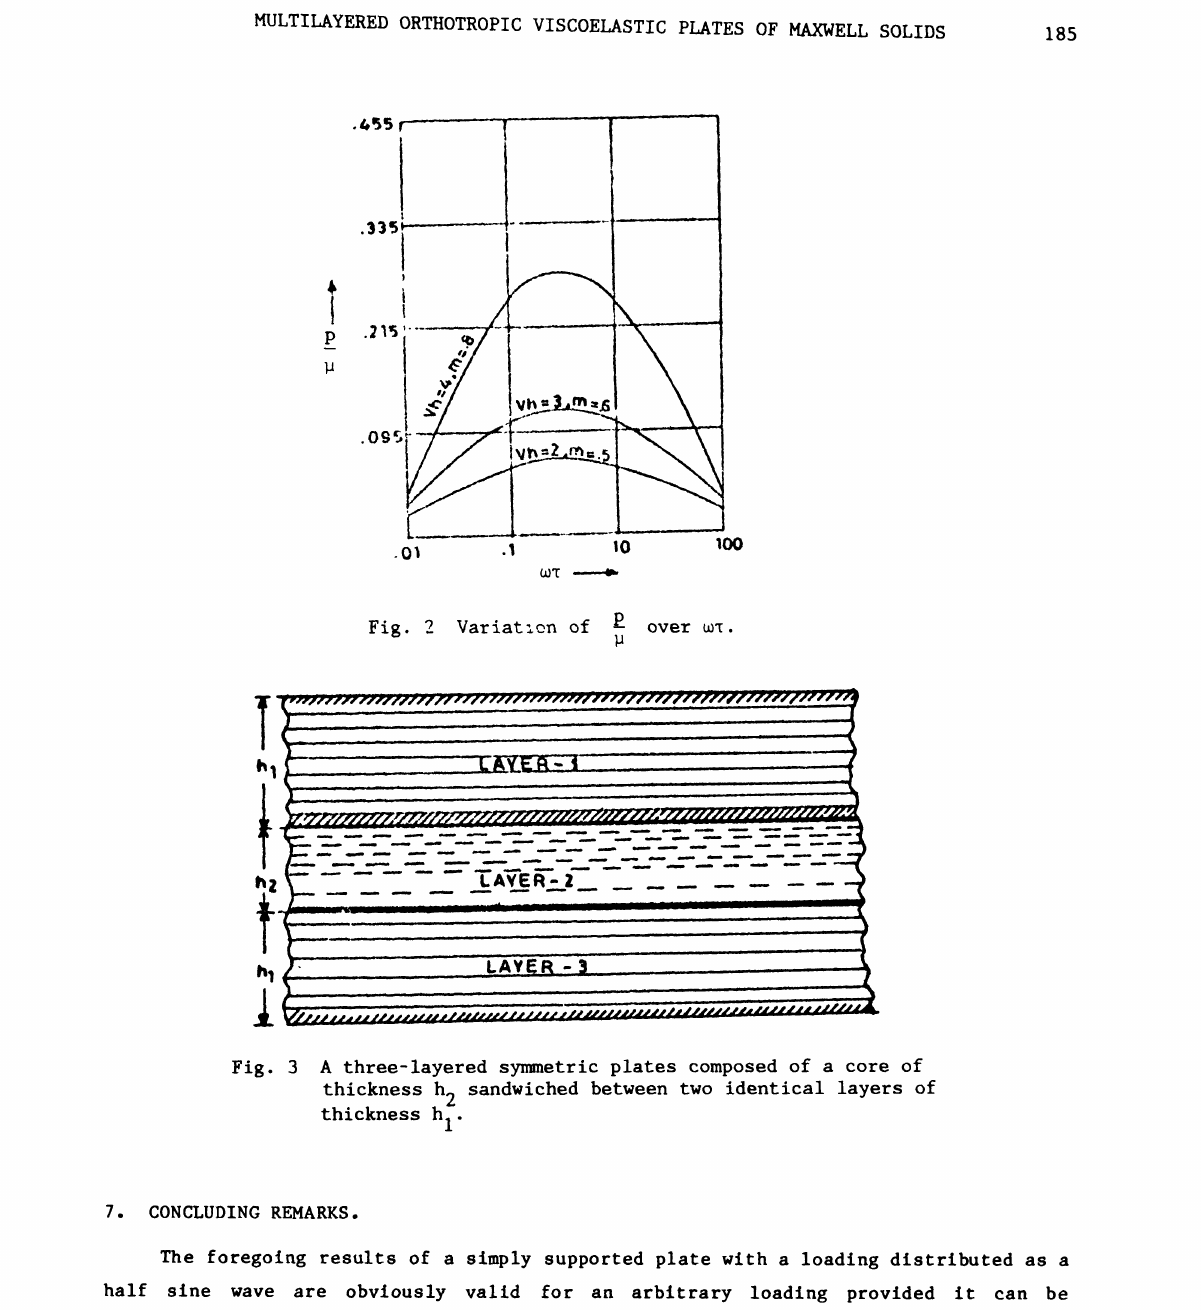
Fig. 3 A three-layered symmetric plates composed of a core of thickness